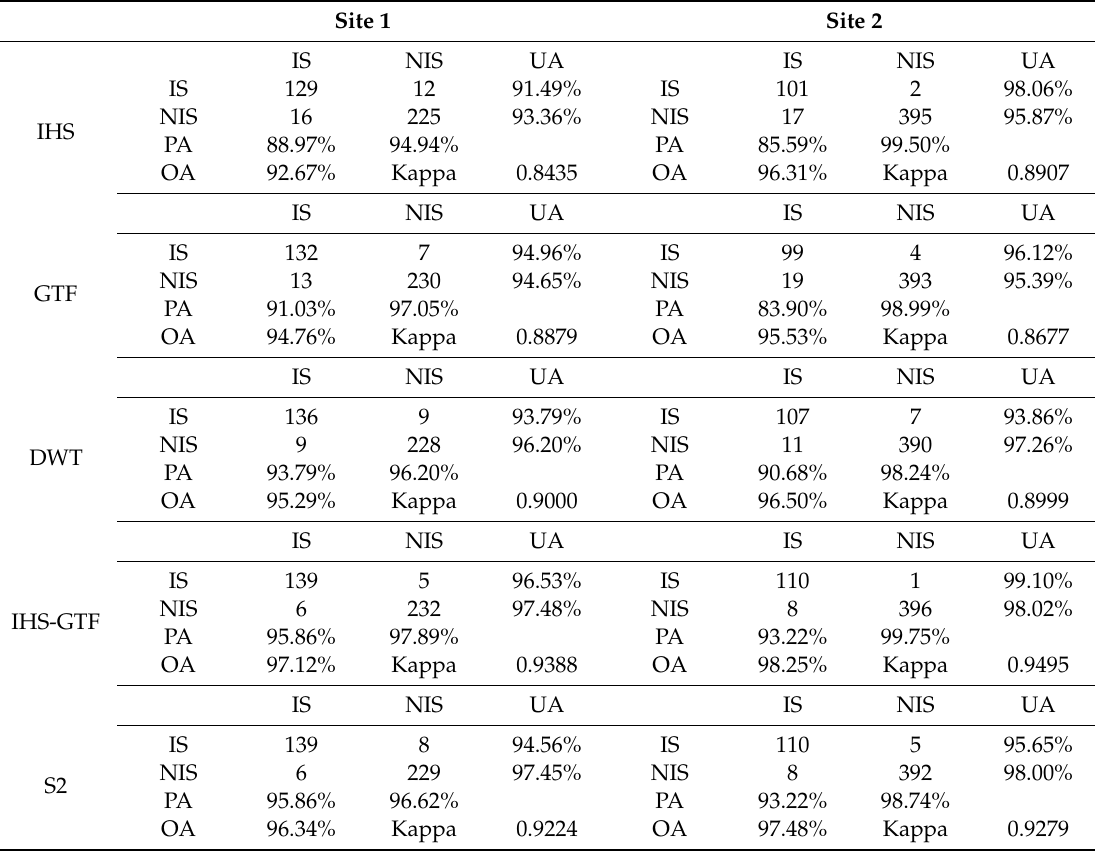
Figure 10. The IS extraction results using di ff erent images in Site 2: ( a – e ) IS results of IHS, GTF, DWT, IHS-GTF, and the Sentinel-2A image, respectively. Table 4. Confusion matrices for the IS extraction using di ff erent